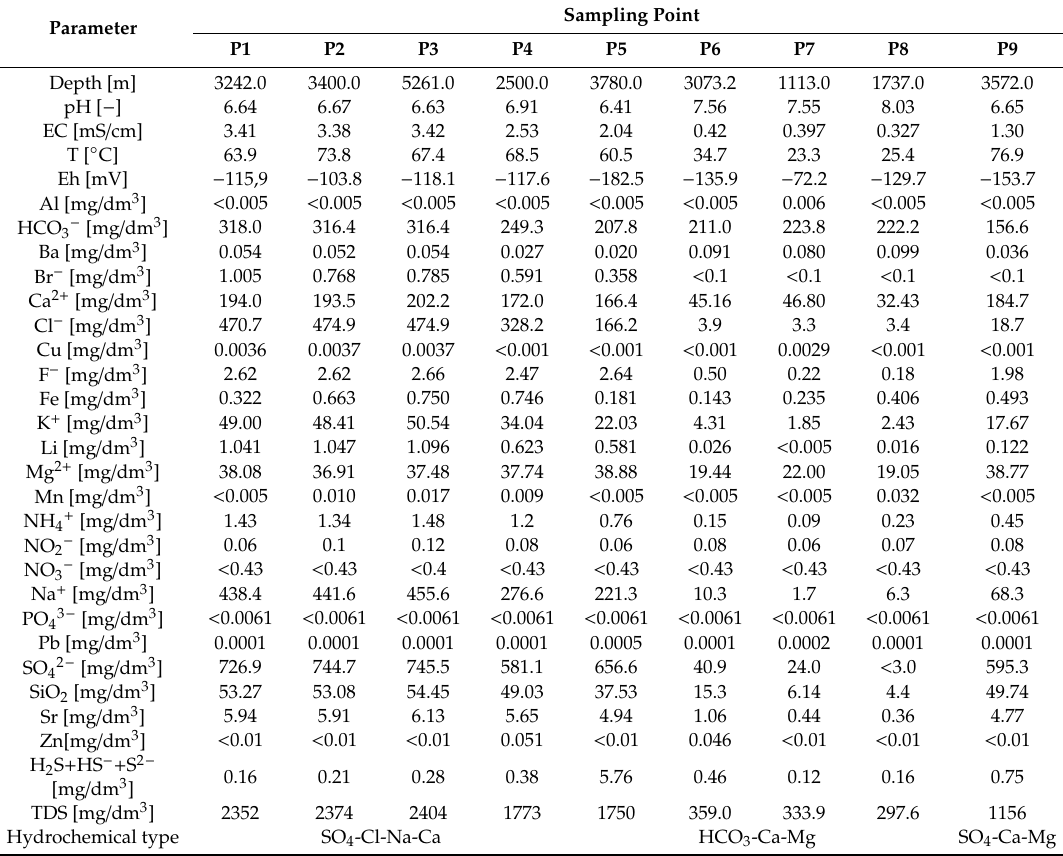
Table 1. Physicochemical parameters of the thermal water samples of the Podhale